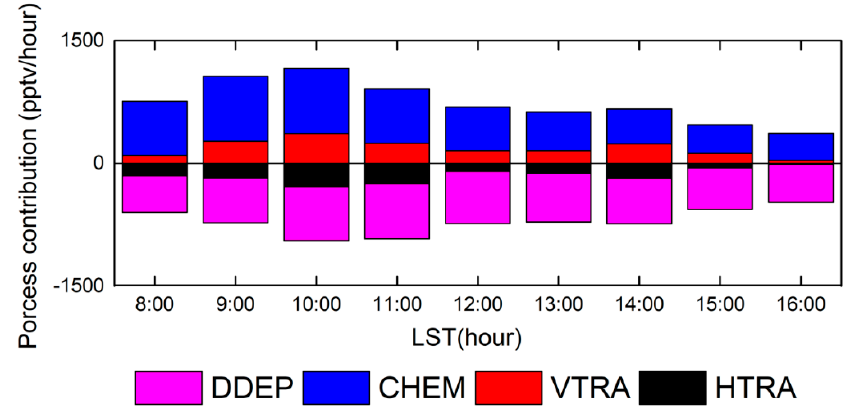
Figure 7. The contributions of different processes to the concentration of PAN at the BGS site.